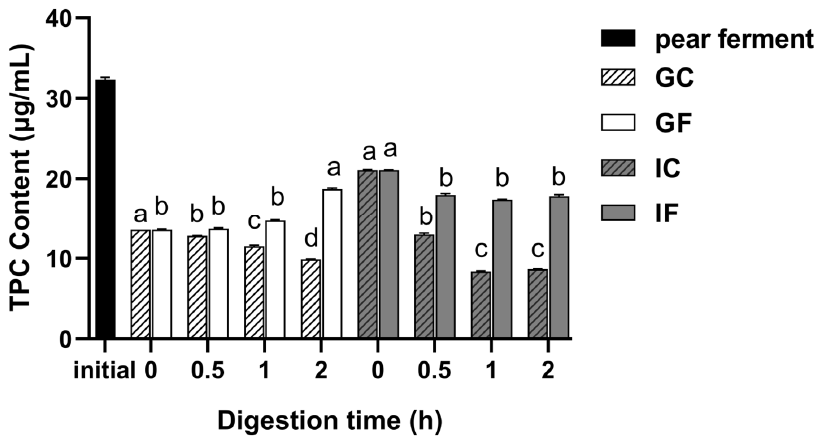
Figure 1. Changes of TPC of ‘Xuehua’ pear ferment during the simulated gastric and intestinal digestion in vitro. Different letters indicate significant differences in the same group under different digestion time ( p < 0.05). Data shown as means ± SD of three replicates ( n = 3).